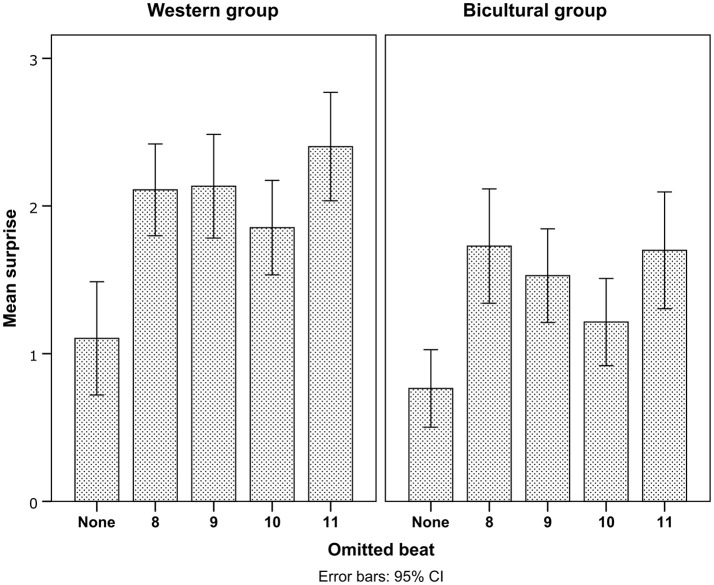
Surprise ratings for all conditions and groups. Error bars indicate 95% confidence intervals.